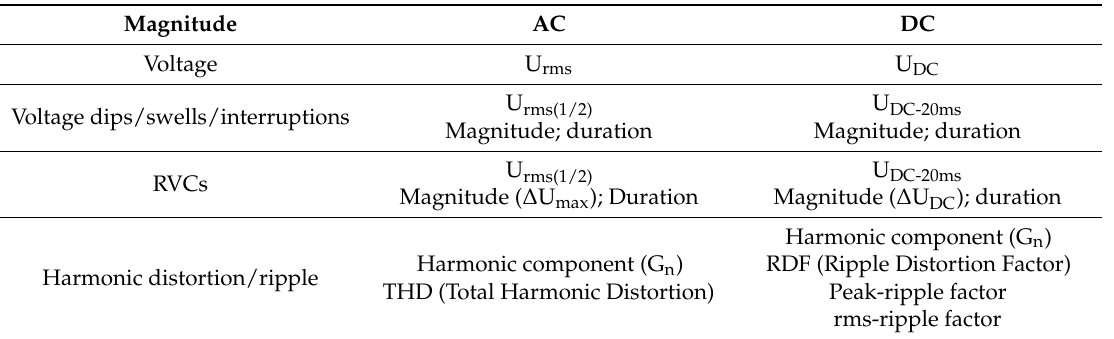
Table 3. Power quality indices in LVDC distribution networks and their corresponding indices in AC